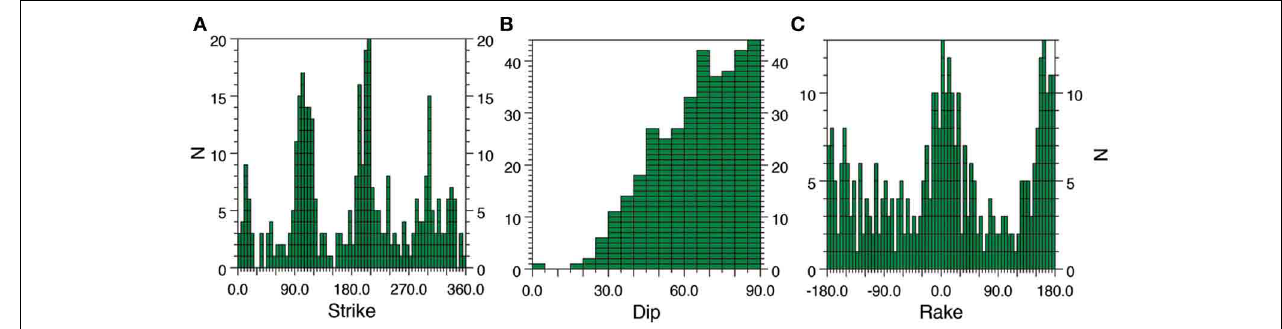
FIGURE 9 | Histograms of the strike (A), dip (B), and rake (C) for both nodal planes of the cluster of the volcanic crisis of 1996 (see section Cluster Selected for Stress